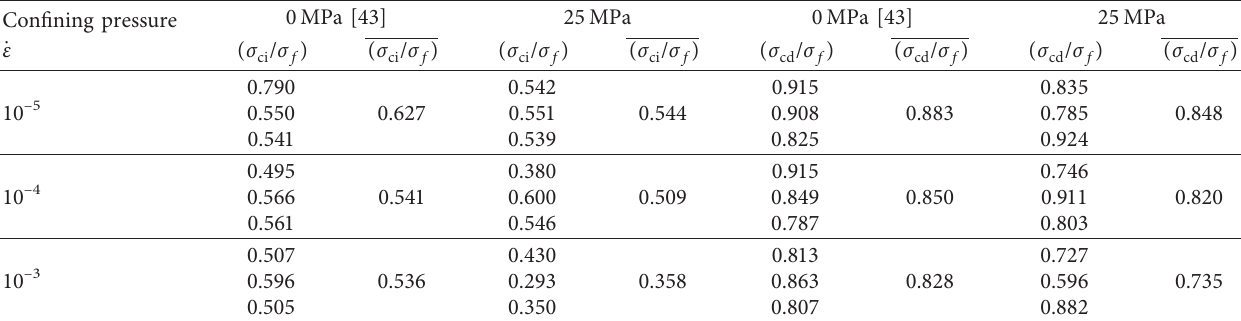
Figure 11: Variation of stress threshold determined by two methods at different strain rates. Table 2: Stress thresholds under uniaxial and triaxial